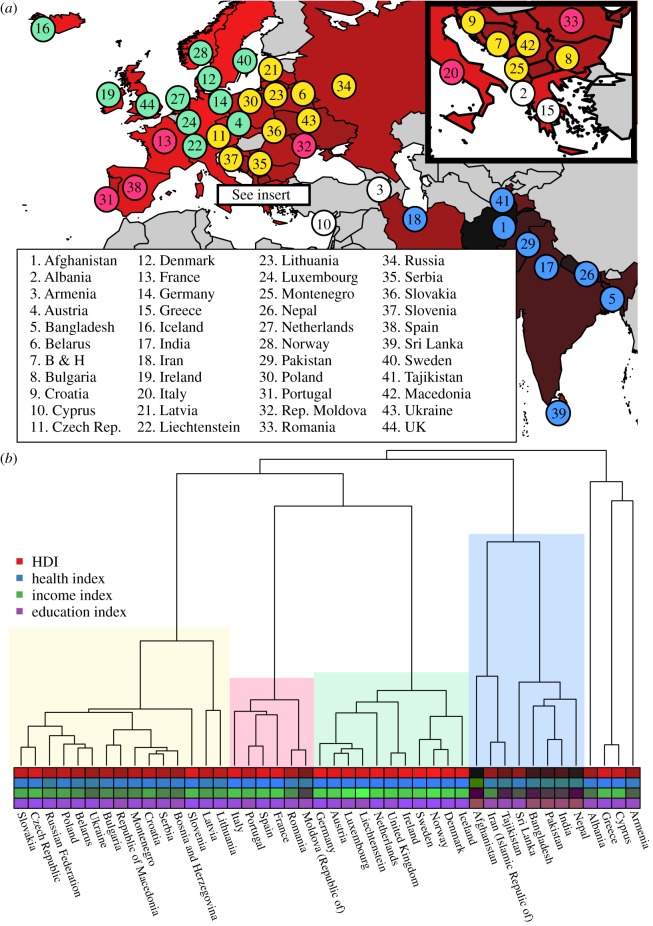
(a) Map showing the location of the 44 countries in our sample. Country regions are coloured according to HDI score from darker (low) to brighter (high). Coloured circles indicate major linguistic sub-groups—Germanic (green), Balto-Slavic (yellow), Italic (pink), Indo-Iranian (blue) and other (white). (b) Maximum clade credibility tree of 44 Indo-European languages corresponding to the countries in our sample, based on a Bayesian posterior sample of 1000 trees. The tips of the tree are colour coded according to HDI and its three subcomponents from darker (low) to brighter (high). Coloured boxes indicate major linguistic sub-groups as in panel (a).